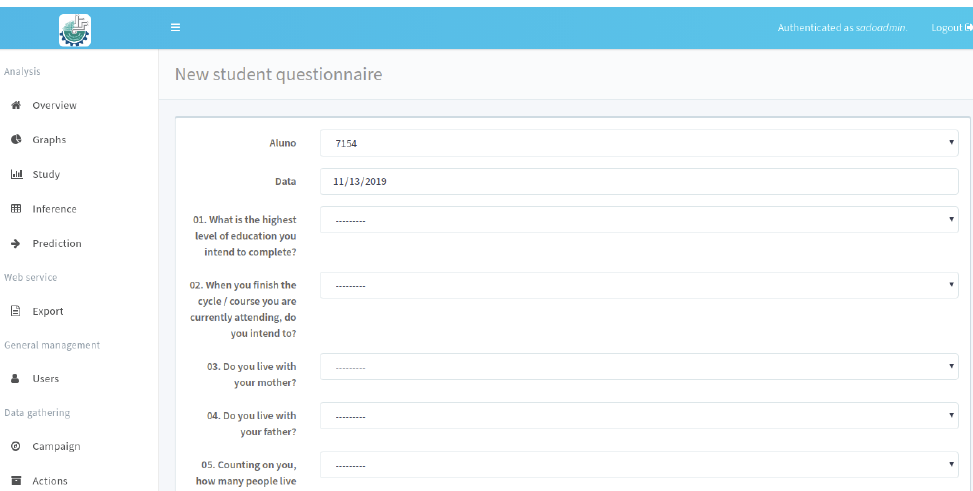
Figure 11. CPO and ceo-d indexes results. Source: Figure elaborated by the own author.